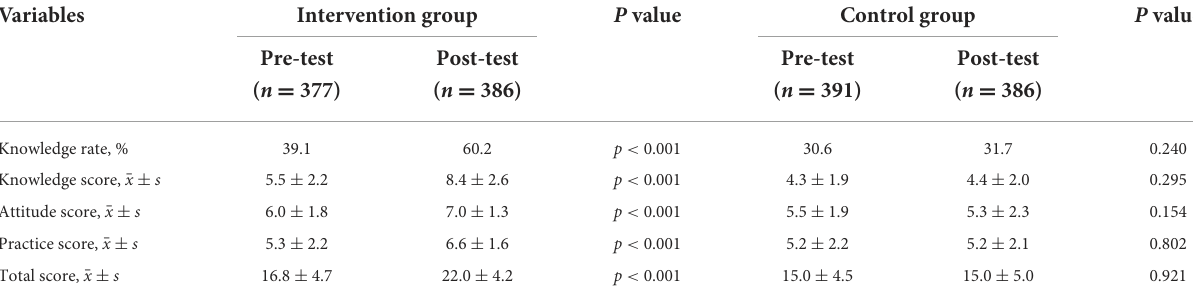
TABLE 3 Differences in knowledge, attitude, practice, and overall score in between intervention and control